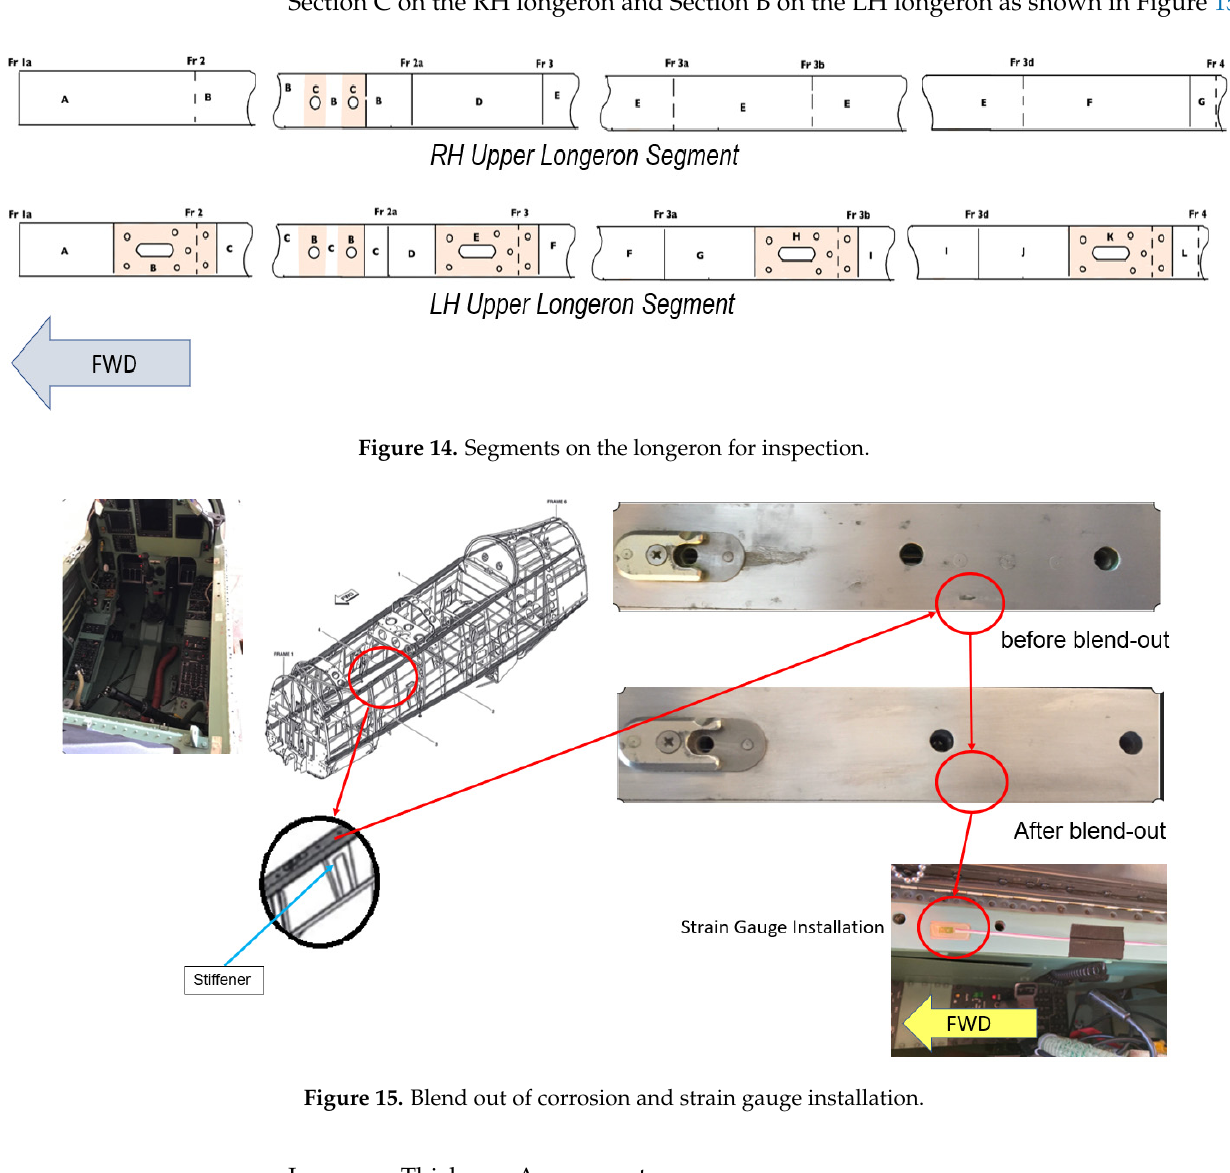
Figure 13. Load applied at the longeron.